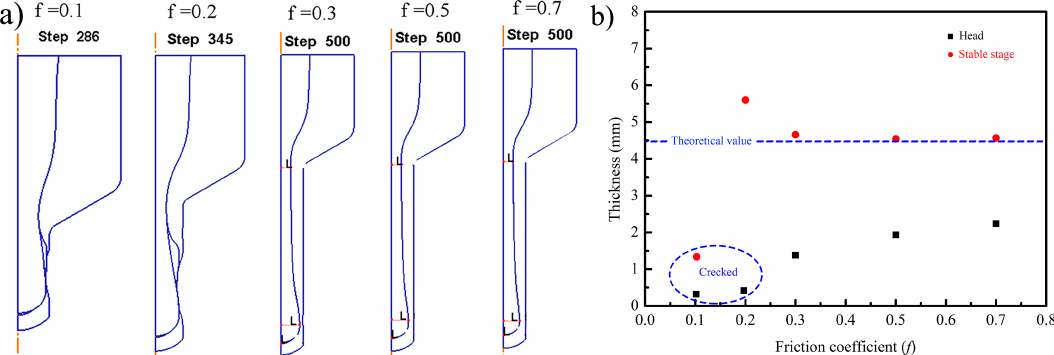
Figure 6. The simulation results of the extrusion process with different friction coefficients: ( a ) the simulation; ( b ) thickness of the head and stable stage.